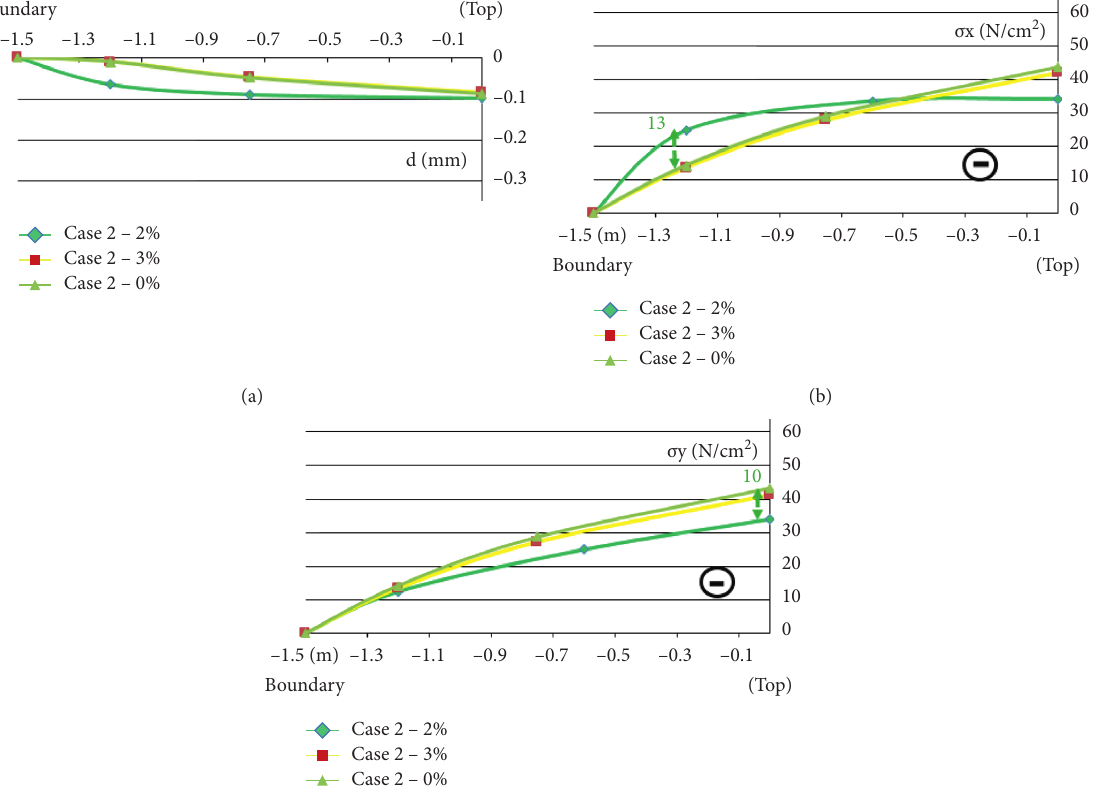
x of shell; (c) stress